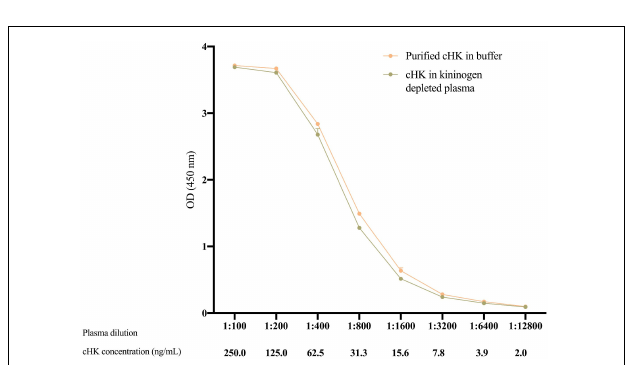
FIGURE 5 | The parallelism between twofold dilutions of purified cHK diluted in buffer and cHK diluted in kininogen depleted plasma was investigated. The cHK levels are given as optical density (OD) at 450 nm. Error bars indicate mean and range of a double